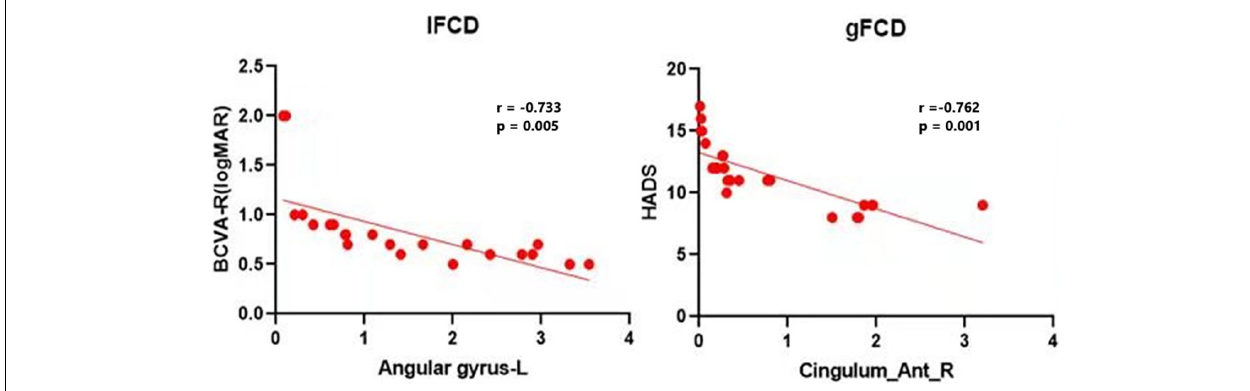
FIGURE 5 | Correlations between the mean IFCD values and BCVA-R (logMAR) and correlations between the mean longFCD values and HADS. There was a negative correlation with the IFCD values of the left angular gyrus and the longFCD values of the right anterior cingulate and paracingulate gyri. IFCD, short-range functional connectivity density; gFCD, long-range functional connectivity density; BCVA-R, best corrected visual acuity of right eye. HADS, Hospital Anxiety and Depression Scale.